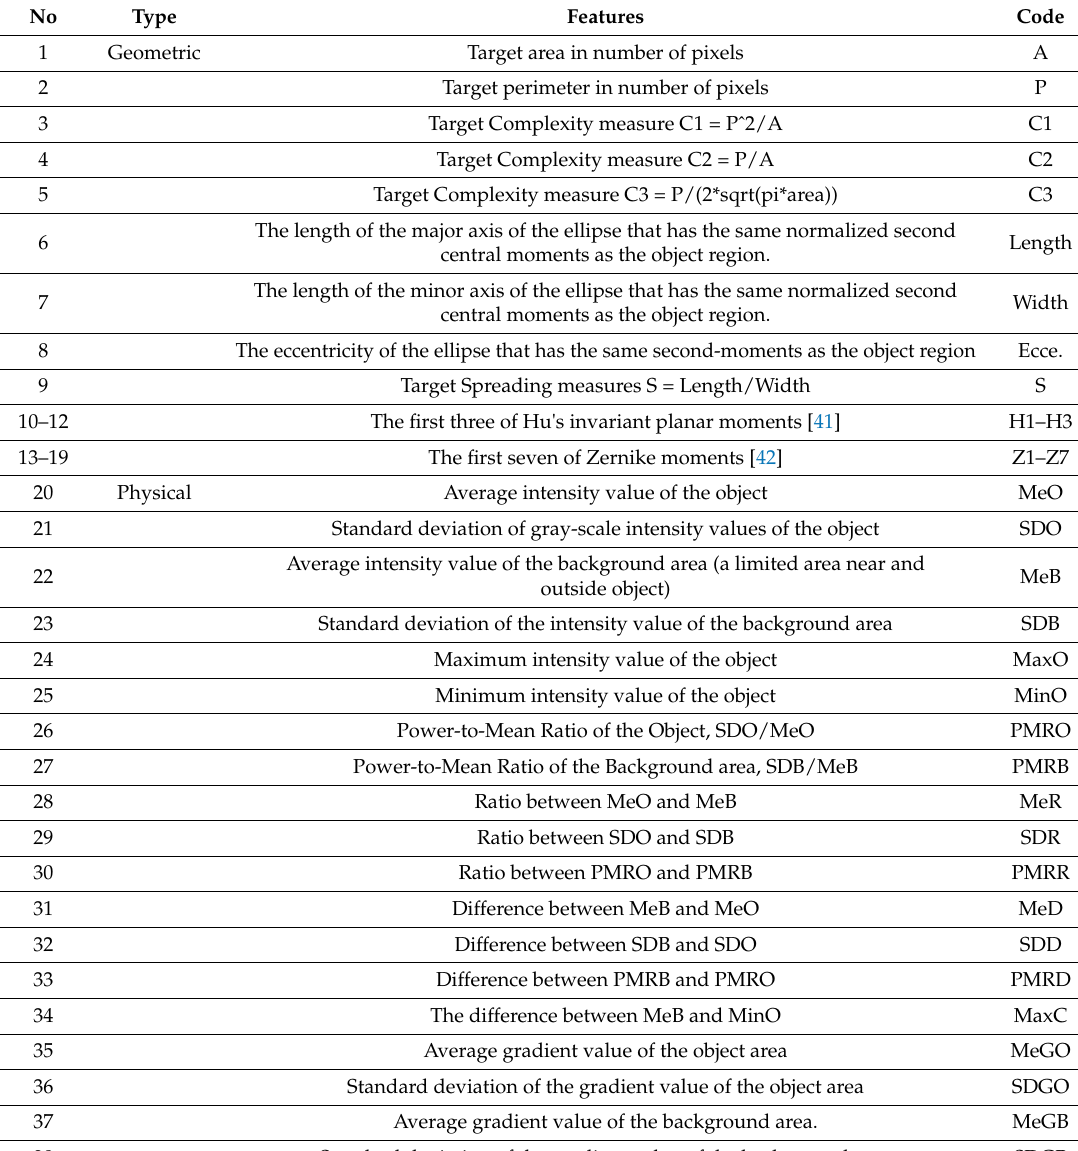
Table 2. Features extracted based on the dark-spot objects for classifying oil spills from look-alikes. No Type Features